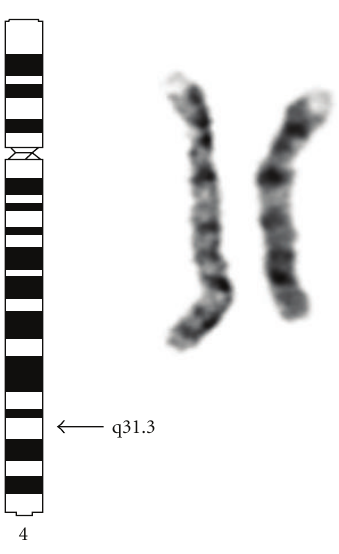
Figure 4: Partial karyotype of the patient, schematic presentation of chromosome 4, right: normal and deleted chromosomes